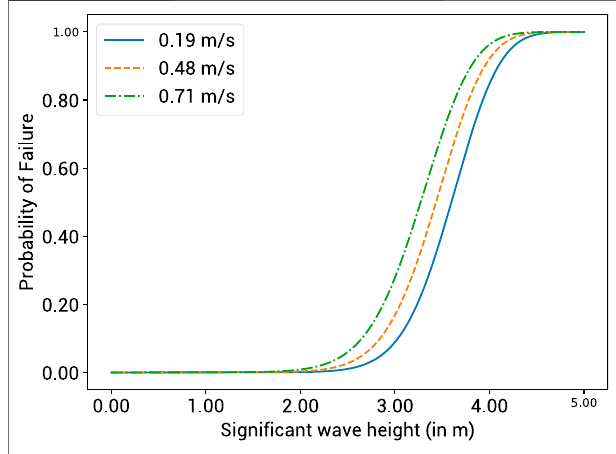
FIGURE 7 | Fragilities of residential post-Andrew buildings for different wave velocities (Vw (cid:1) 0.18, 0.63, 0.865 m/s).